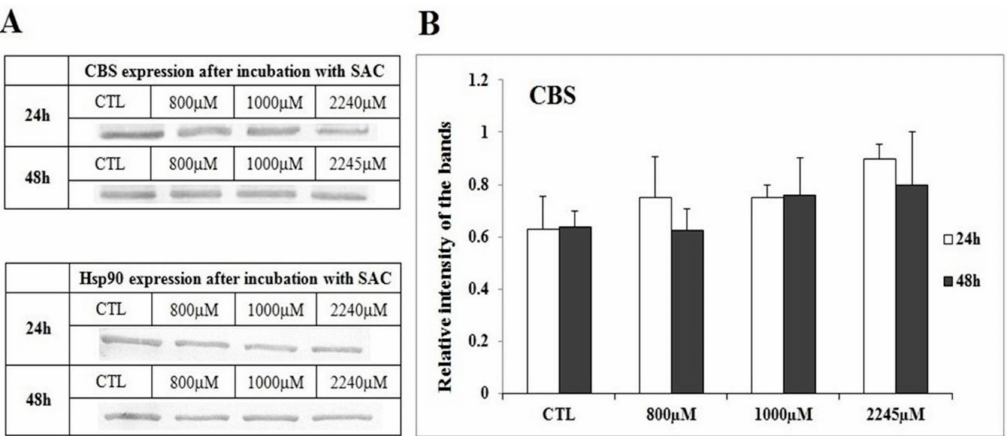
Figure 3. The expression of cystathionine β -synthase (CBS), in the breast cancer cell line (MCF-7) after the 24 h and 48 h incubations with 800 µ M, 1000 µ M and 2245 µ M SAC. The tested concentrations of SAC in culture medium as listed: 800 µ M, 1000 µ M and 2245 µ M, and the control refers to non-treated cells. ( A ) Western blot with immunodetection. Each experiment was done tree times in triplets, and a representative experiment is shown. Hsp90 is used as a control of equal loading. ( B ) Densitometric visualization of expression of CBS. The error bars represent standard deviation.